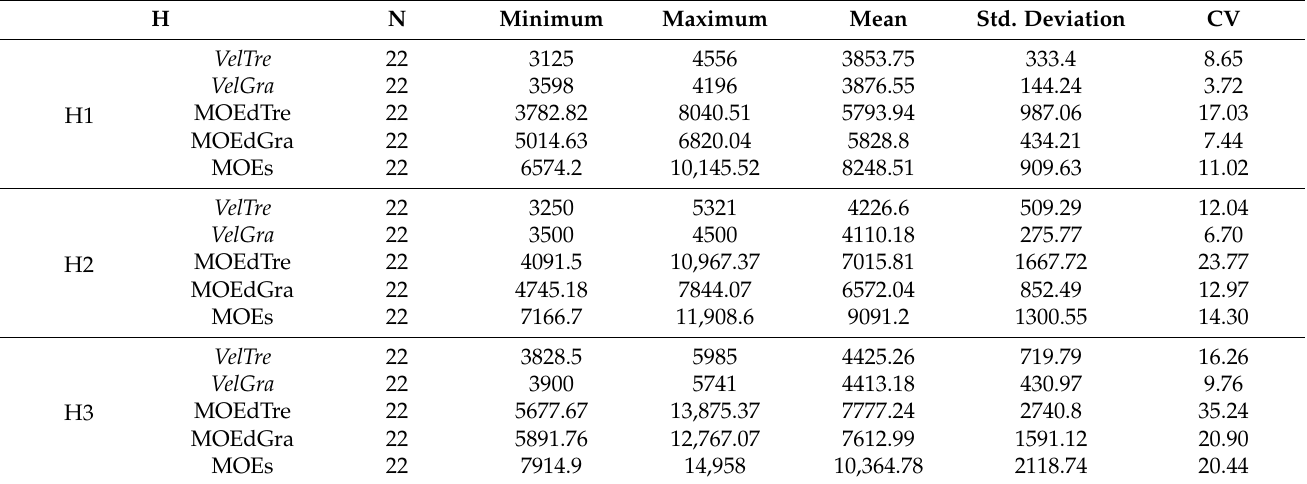
Table 2. Descriptive statistics of the stress velocities of the sound wave (m s − 1 ) on standing trees ( VelTre ) and logs ( VelGra ) and of the calculated dynamic and static elastic modules (MPa). The variables were split along the three designated stem heights